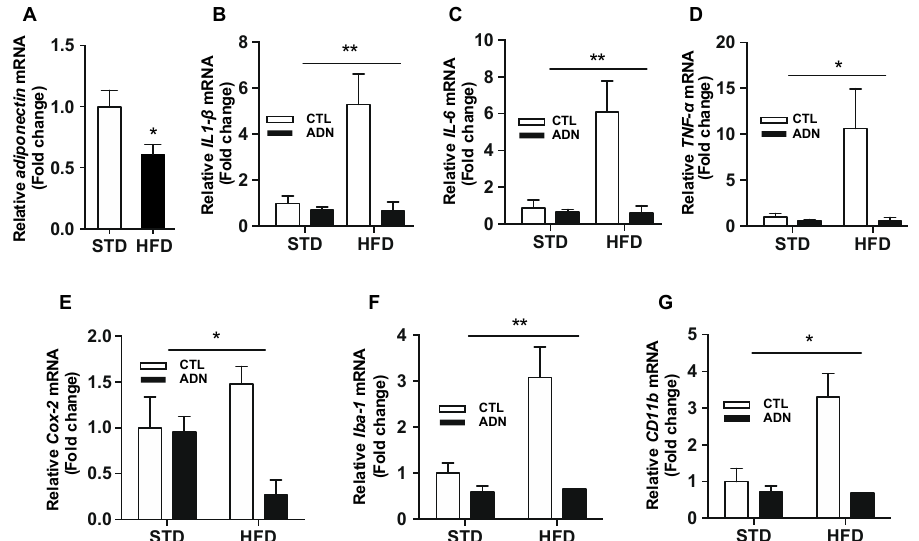
Figure 1. Systemic administration of adiponectin reverses the hypothalamic inflammation in response to short-term HFD treatment. C57BL / 6 mice were fed either a Standard diet (STD) or a HFD for 4 weeks followed by i.p. injection of adiponectin or saline (as a control group) for 5 days. ( A ) The level of adiponectin mRNA in eWAT was significantly elevated 4 weeks after HFD treatment. The elevated mRNA levels of hypothalamic genes involved in inflammatory processes such as ( B ) IL-1 β , ( C ) IL-6 , and ( D ) TNF- α and ( E ) Cox-2 observed in HFD-treated group were significantly reversed by i.p administration of adiponectin. Adiponectin treatment dampened the increase in the mRNA levels of hypothalamic ( F ) Iba-1 and ( G ) CD11b , markers for microglia activation, in response to HFD treatment. Results are presented as mean ± SEM. n = at least 5 mice per group. * p < 0.05, ** p < 0.01 for e ff ects of adiponectin on HFD-treated group versus e ff ects of adiponectin on STD-treated group. CTL, control group; ADN, adiponectin-treated